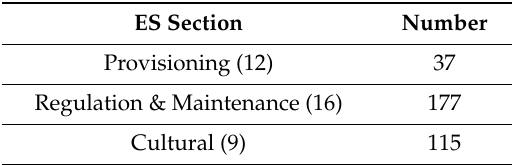
Table 2. Overview of assessed ecosystem services (ES) sections and classes (numbers in brackets) according to CICES V5.1 in regard to urban green